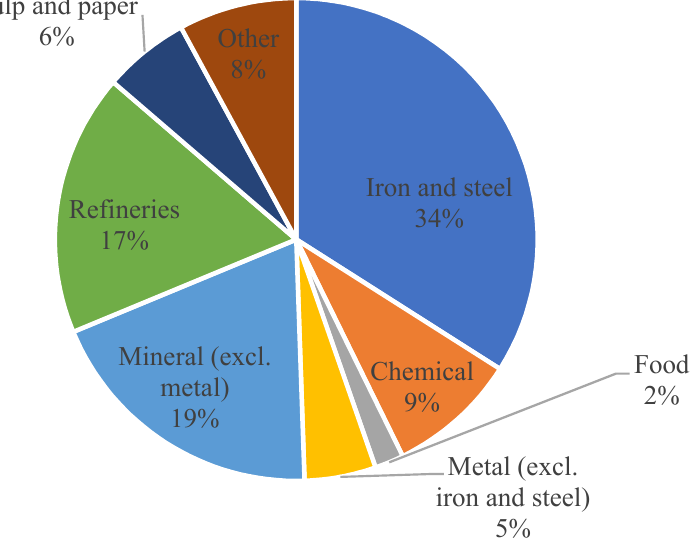
Figure 4. Greenhouse gas emissions from Swedish industry in 2018, as a percentage of total industrial emissions. Source: Swedish Environmental Protection Agency [45].